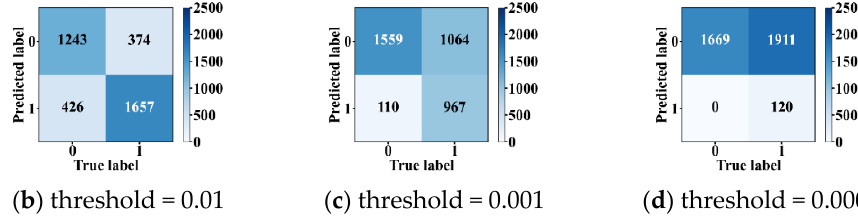
Figure 15. Confusion matrixes of the YOLOv4 models developed by the experimental dataset with image size 480 × 480 and noise intensity 0 under different pre-determined thresholds. Note that label 0 represents the existing gas leakage and label 1 represents no gas leakage. The predefined thresholds were determined according to the classification probability outputted by the YOLOv4 model.